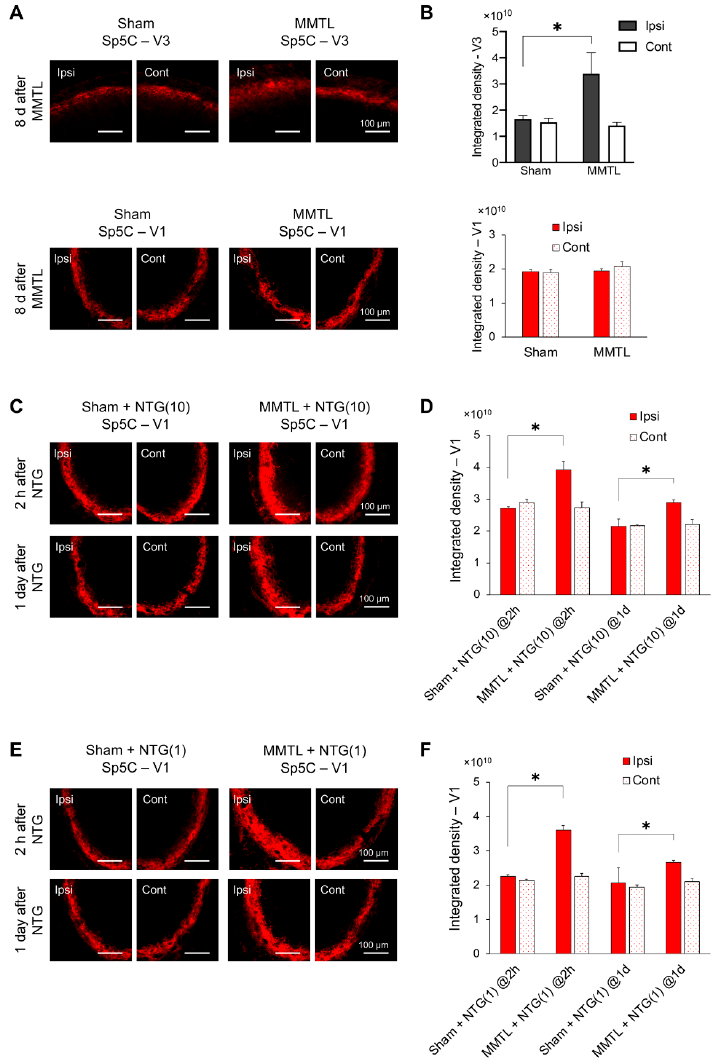
Figure 5. E ff ect of MMTL pretreatment on the protein level of CGRP in the Sp5C after NTG injection. ( A ) Representative immunofluorescent staining images of CGRP in the rostral Sp5C-V3 and caudal V1 area from sham and MMTL groups on day 8 after surgery. ( B ) Quantification of integrated densities of CGRP in the Sp5C ( n = 3 mice per group). ( C , E ) Representative immunofluorescent staining images of CGRP in the caudal Sp5C-V1 from sham or MMTL plus the higher dose (10 mg / kg) of NTG groups ( C ), and sham or MMTL plus the lower dose (1 mg / kg) of NTG groups ( E ). ( D , F ) Quantification of integrated densities of CGRP in the caudal Sp5C-V1 ( n = 3 mice per group). Note that MMTL significantly increased CGRP in the ipsilateral rostral Sp5C-V3, but had no e ff ect on the CGRP protein level in the caudal Sp5C-V1 compared with the sham-treated group ( A , B ), and that MMTL pretreatment significantly increased CGRP in the ipsilateral caudal Sp5C-V1 after NTG injection of both higher dose (10 mg / kg, E , F ) and lower dose (1 mg / kg, C and D ). * p < 0.05 vs. the respective control groups. F treatment (1, 8) = 3.725, p = 0.90; F side (1, 8) = 6.384, p < 0.05; F interaction (1, 8) = 4.951, p = 0.057 for the rostral Sp5C-V3. F treatment (1,8) = 1.472, p = 0.260; F side (1,8) = 0.225, p = 0.648; F interaction (1,8) = 0.838, p = 0.387 for the caudal Sp5C-V1 in ( B ). F treatment (3,16) = 15.100, p < 0.001; F side (1,16) = 11.28, p < 0.005; F interaction (3,16) = 6.426, p < 0.05 for ( D ). F treatment (3,16) = 10.750, p < 0.001; F side (1,16) = 20.07, p < 0.005; F interaction (3,16) = 5.746, p < 0.05 for ( F ). CGRP: calcitonin gene-related peptide; MMTL: masseter muscle tendon ligation; NTG: nitroglycerin; NTG(1): 1 mg / kg of nitroglycerin; NTG(10): 10 mg / kg of